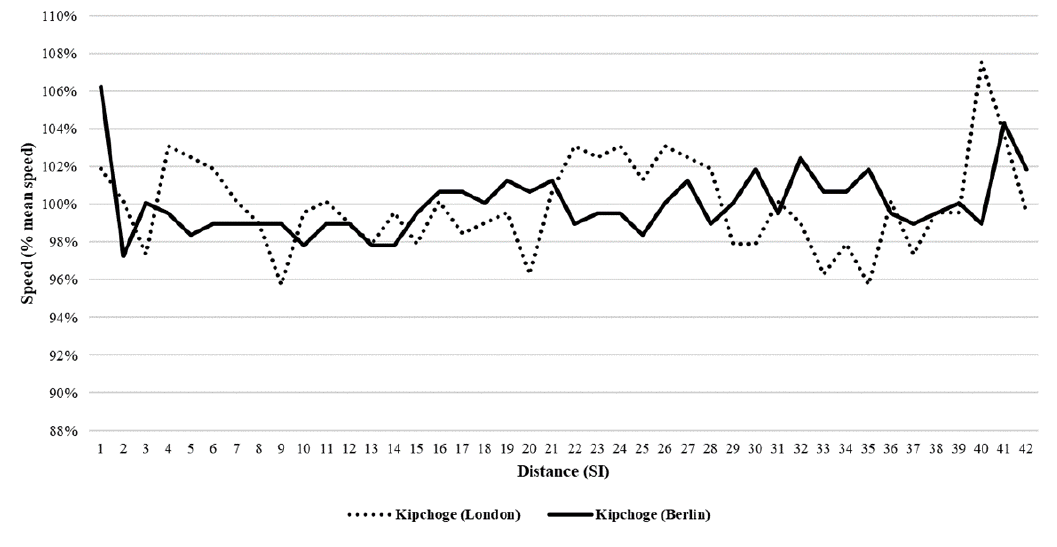
Figure 1. Speed trend and asymmetry characteristics in the world’s fastest male marathoner. The curve (dotted line) represents the time course of Eliud Kipchoge’s running speed during the London marathon in 2019. The curve (dashed line) represents the time course of his running speed during the Berlin marathon in 2018. These curves represent the percentage of the mean speed achieved in each distance unit during the entire marathon.